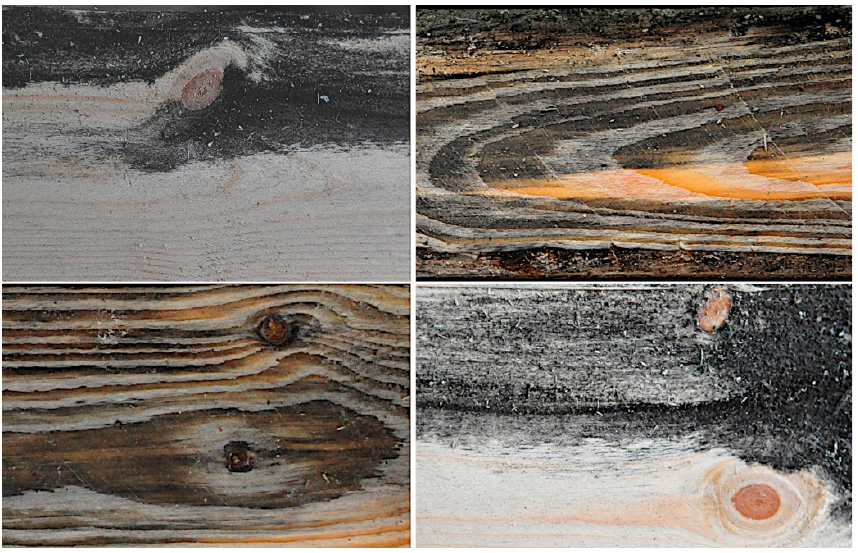
Figure 1. Examples of fungal infections: the fungus Ceratocystis pinicola visible on the surface of boards delivered from the sawmill.